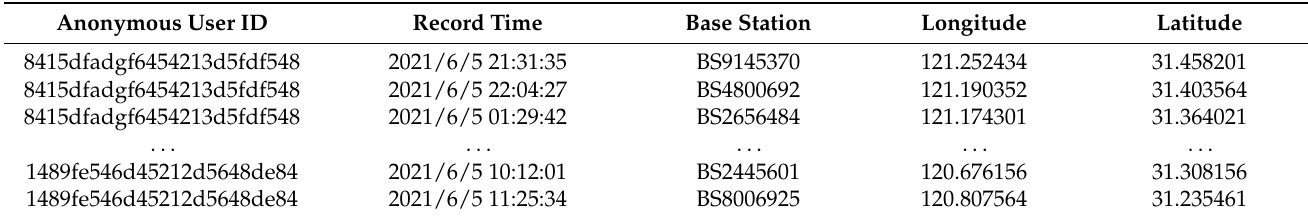
Table 1. Mobile signal data